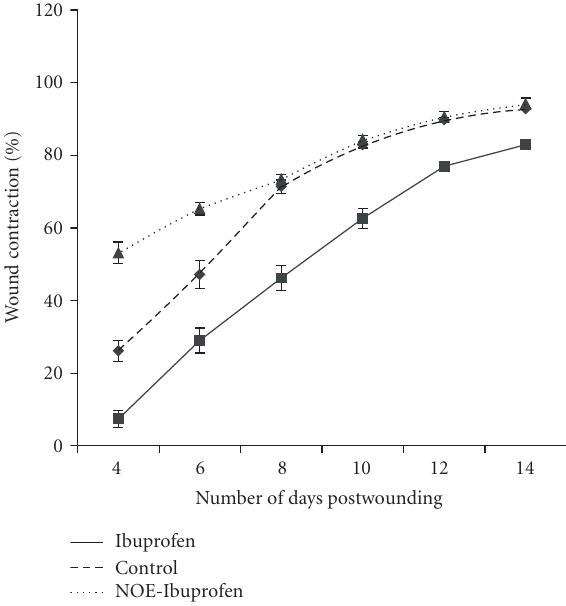
Figure 2: E ff ect of drugs on wound contraction. Contraction was studied by tracing the raw wound area on tracing paper on predetermined days, namely, days 4, 6, 8, 10, 12, 14, and 16 or till completion of healing, whichever was earlier. Ibuprofen group has significantly ( P < . 05) lesser contraction than control group. NOE-ibuprofen has significantly ( P < . 05) more contraction than ibuprofen.